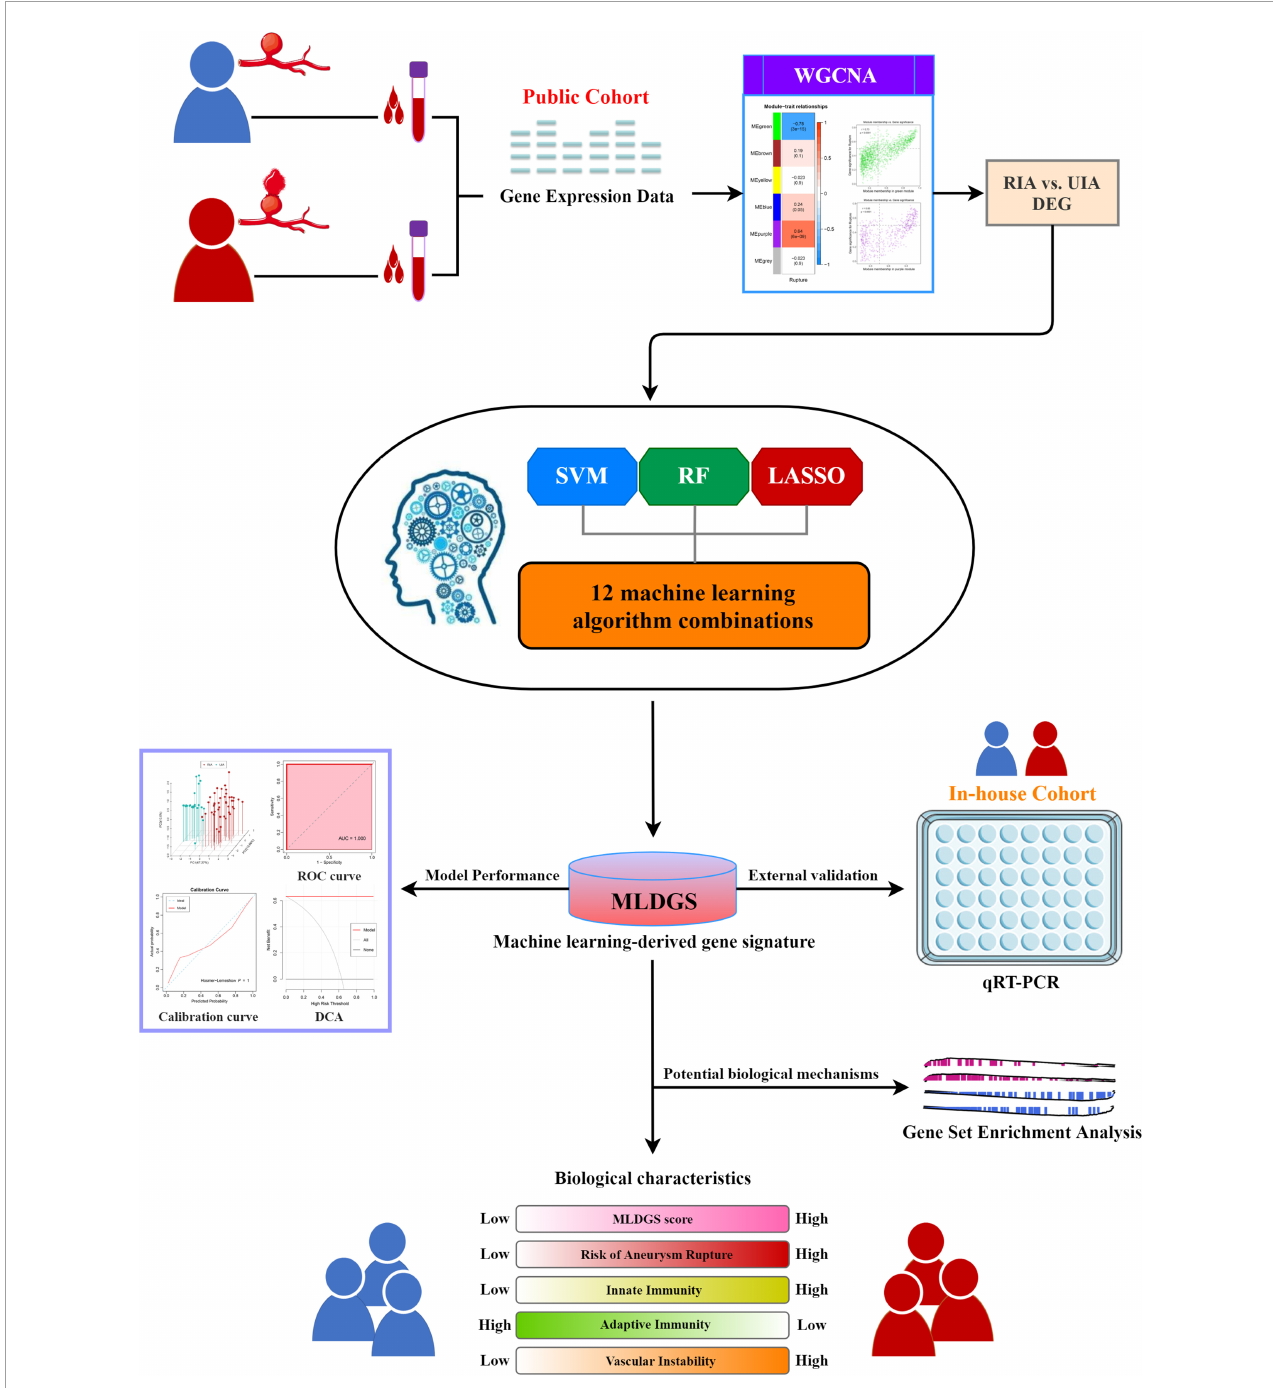
FIGURE1 The overall workflow of this study.